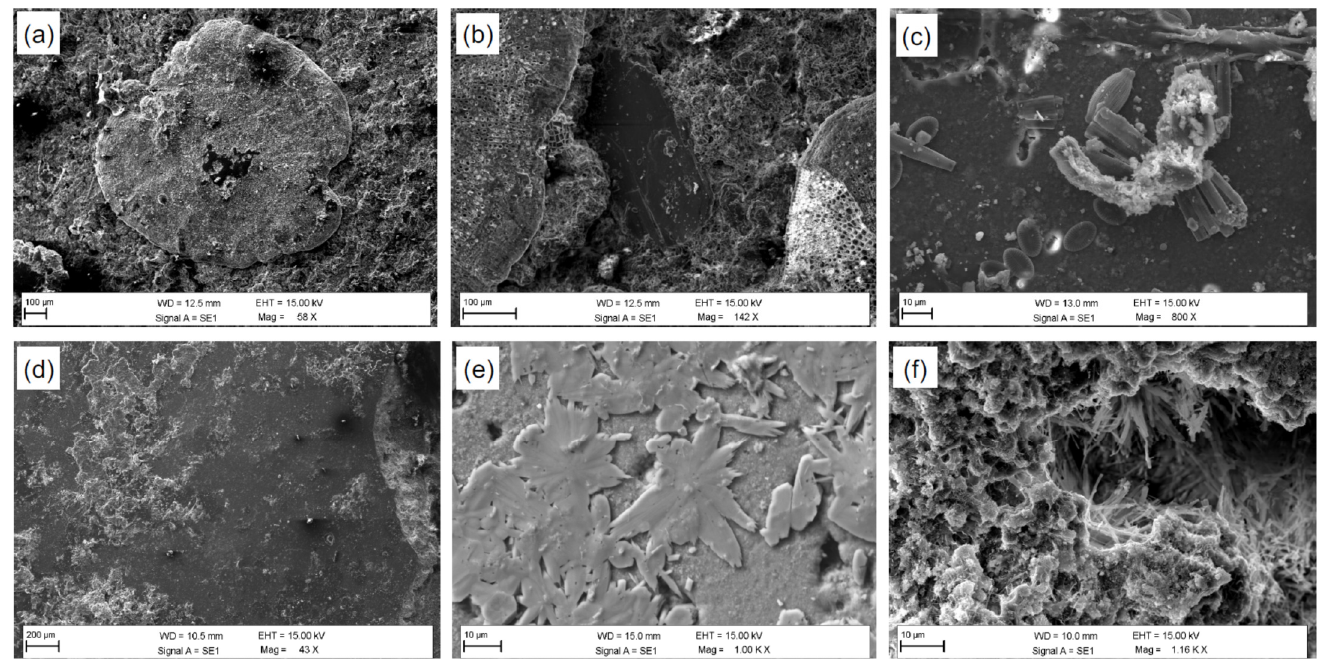
Figure 4. Representative SEM-BSE images of mortar specimens without ( a – c ) and with magnesium- based additives ( d – f ). Specifically: ( a , b ) deposits of crustose calcareous algae with honeycomb-like thalli; ( c ) diatoms; ( d – f ) new mineral phases, different in shape and size, covering the entire investigated area.